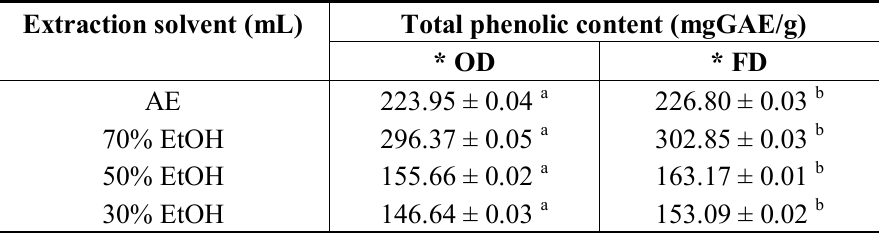
Table 1. Total phenolic constituents of S. asper leaves aqueous and ethanol extracts from oven dried (OD) and freeze dried (FD)